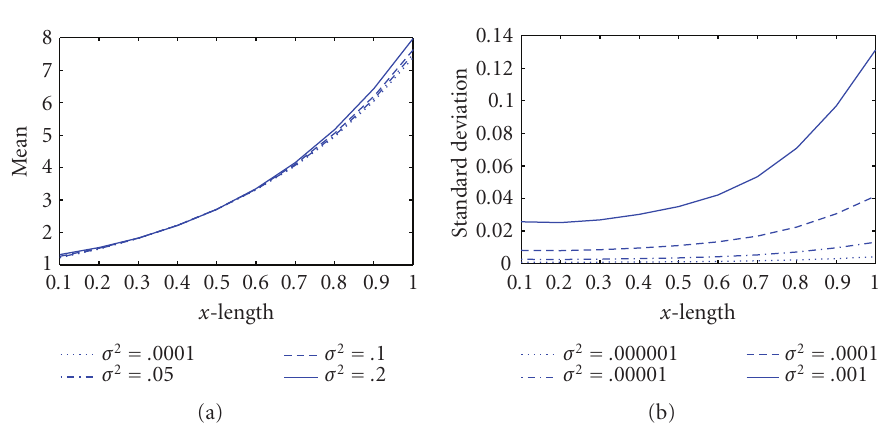
Figure 6.3. The e ff ect of σ 2 on the solution moments at stochastic heat conductivity A . (a) E ff ect of σ 2 on the mean of solution at t = 1second. (b) E ff ect of σ 2 on SD of the solution at t = 1second.